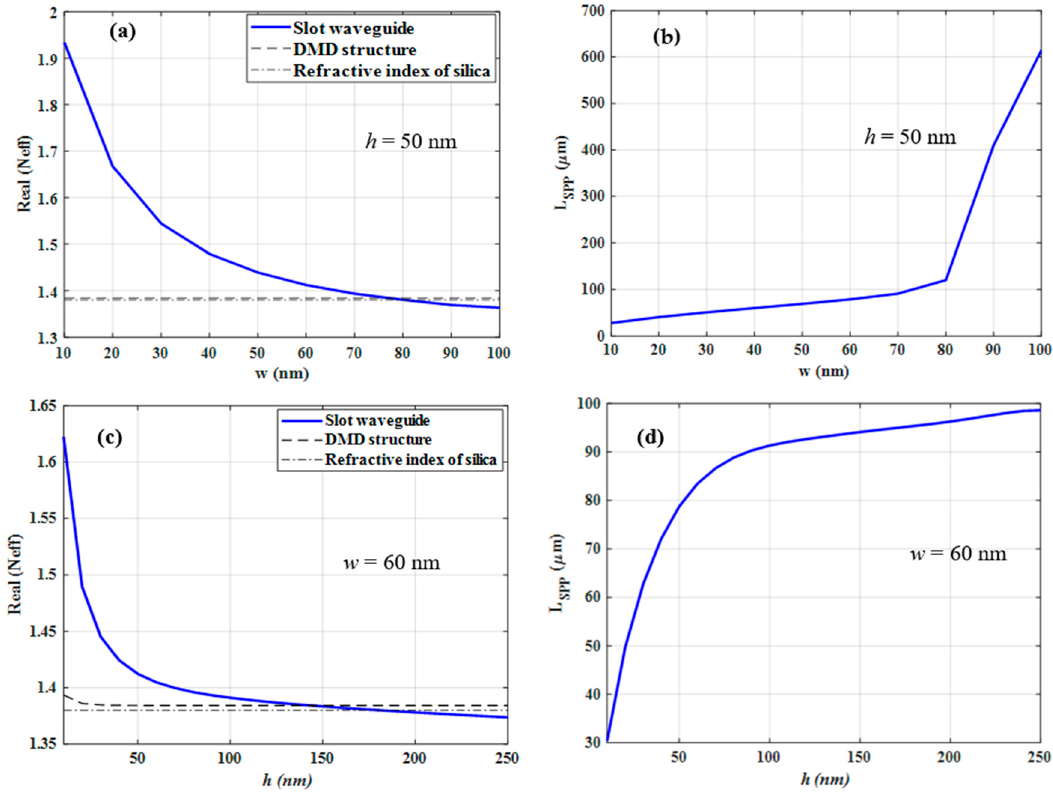
Figure 6. ( a ) The variation of the effective mode index ( N ef f ) of the fundamental mode of the asymmetric PSWG as a function of the slot width ( w ) when the gold thickness is fixed to 50 nm. ( b ) The propagation length of the asymmetric PSWG as a function of the slot width w . ( c ) The effective mode index of the fundamental mode of the asymmetric PSWG as a function of the gold thickness ( h ) when the gap width is 60 nm. ( d ) The propagation length of asymmetric PSWG as a function of the gold thickness h .